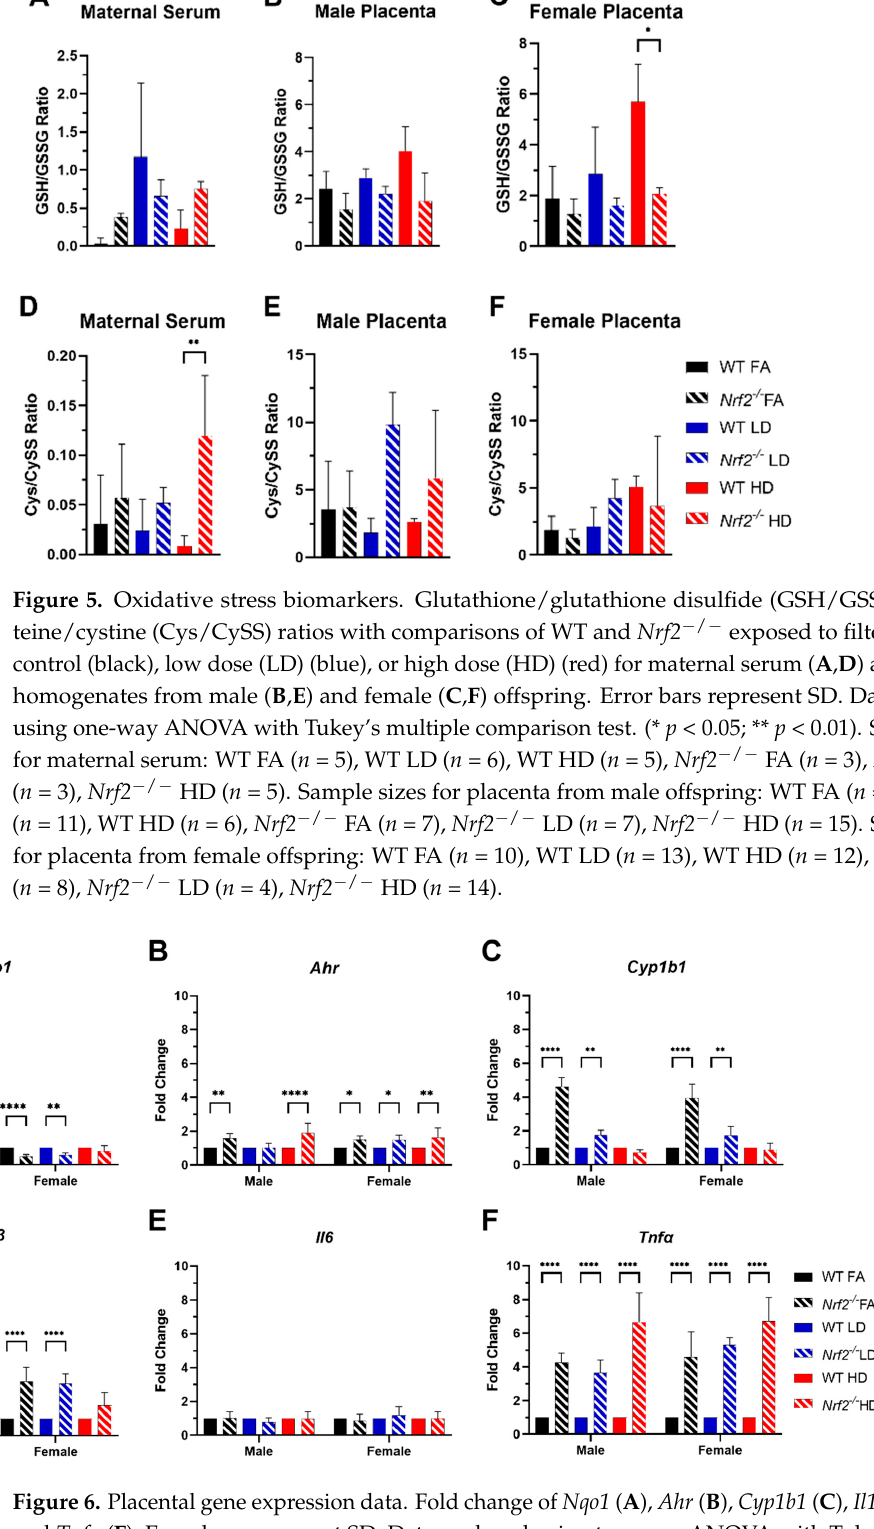
Figure 6. Placental gene expression data. Fold change of Nqo1 ( A ), Ahr ( B ), Cyp1b1 ( C ), Il1 β ( D ), Il6 ( E ) and Tnf α ( F ). Error bars represent SD. Data analyzed using two-way ANOVA with Tukey’s multiple comparison test. (* p < 0.05; ** p < 0.01; *** p < 0.001; **** p < 0.0001). Male placenta homogenate numbers include WT FA ( n = 6), WT LD ( n = 11), WT HD ( n = 6), Nrf2 − / − FA ( n = 8), Nrf2 − / − LD ( n = 7), and Nrf2 − / − HD ( n = 15). Female placenta homogenate numbers include WT FA ( n = 10), WT LD ( n = 13), WT HD ( n = 12), Nrf2 − / − FA ( n = 8), Nrf2 − / − LD ( n = 4), and Nrf2 − / − HD ( n = 14).